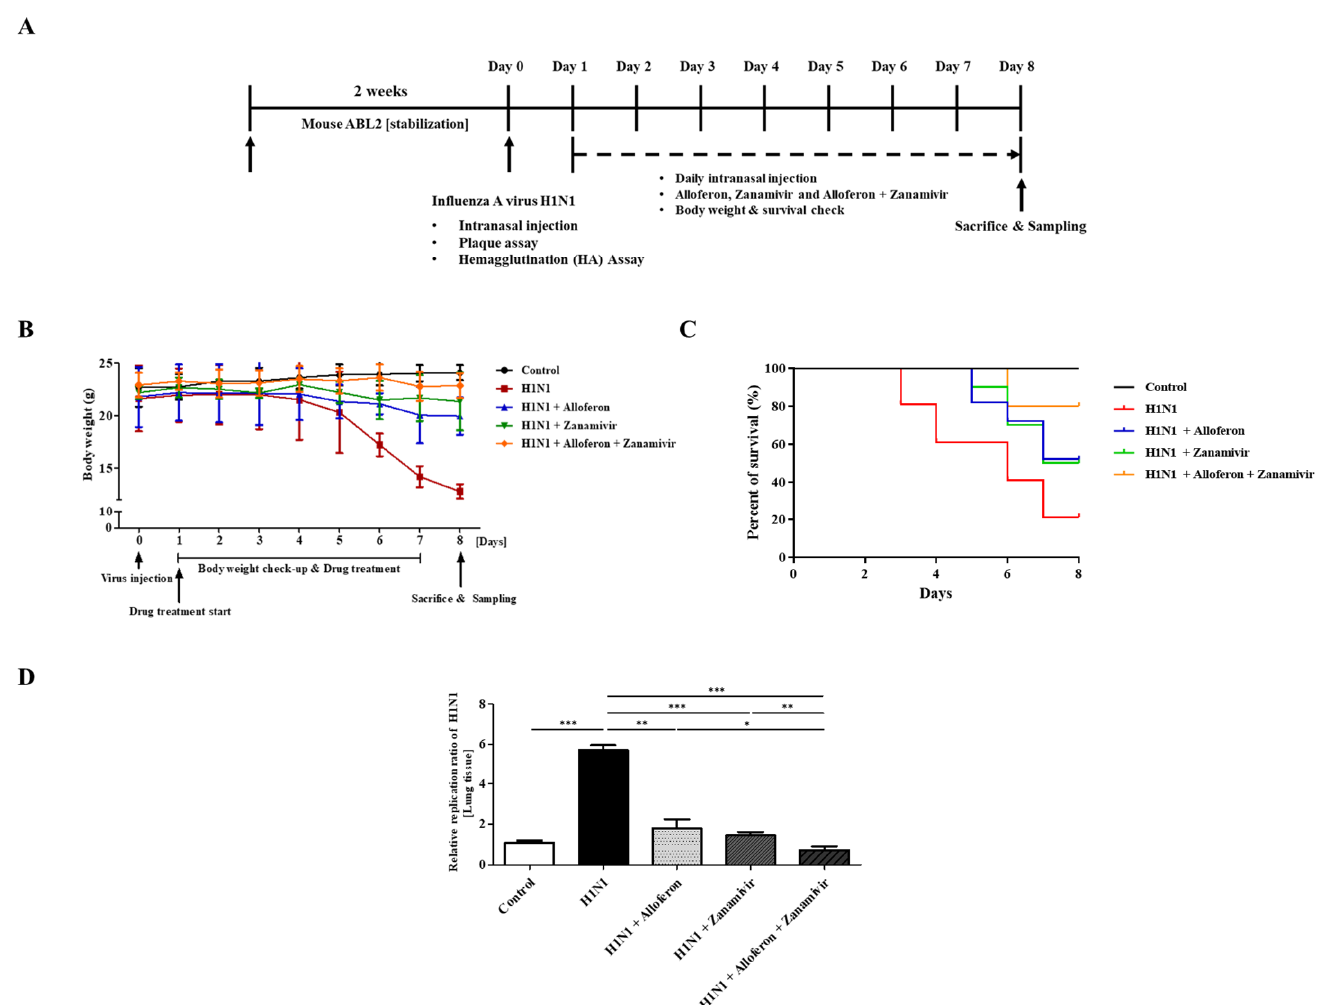
Figure 4. Combined treatment with alloferon (0.5 µ g/mL) and zanamivir (35 µ g/mL) increased the survival rate of mice infected with H1N1 by inhibiting replication of the virus. ( A ) Intranasal infection of mice with H1N1 (1:32 diluted in saline) was performed after measurement of the effective viral titer using an HA assay (Supplementary Figure S5). At 24 h post-virus infection, a daily dose of alloferon and/or zanamivir was administered intranasally in mice ( n = 30/group) for seven days. ( B ) Body weight and ( C ) survival were monitored for an additional eight days. ( D ) Total RNA was extracted from lung tissues and an analysis of viral replication was performed using real-time PCR as described in the Materials and Methods section. Results are representative of more than three independent experiments. * p < 0.1, ** p < 0.01, *** p < 0.001.